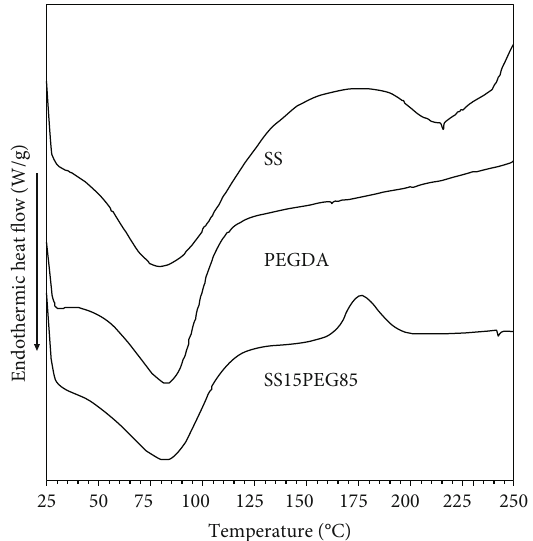
7: X-ray di ff raction of the freeze-dried samples: (a) SS powder, (b) PEGDA hydrogel, and (c) SS15PEG85